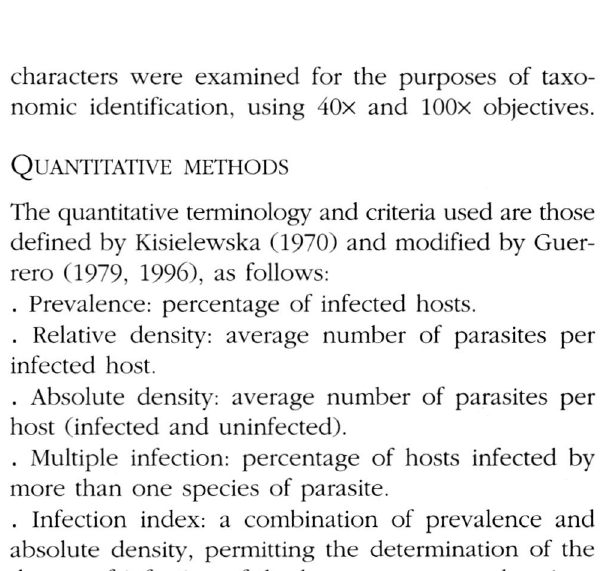
Table I. - Environmental characteristic in the studied localities.